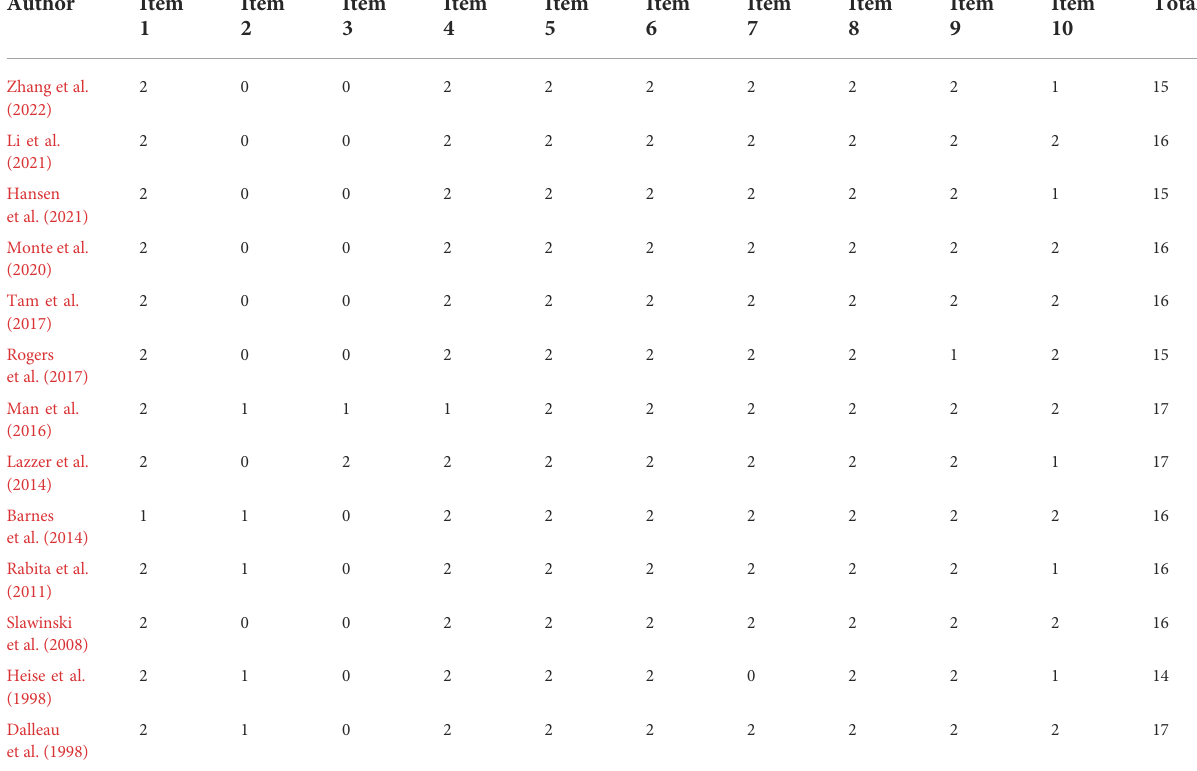
TABLE 2 Methodological quality evaluation for the included studies.